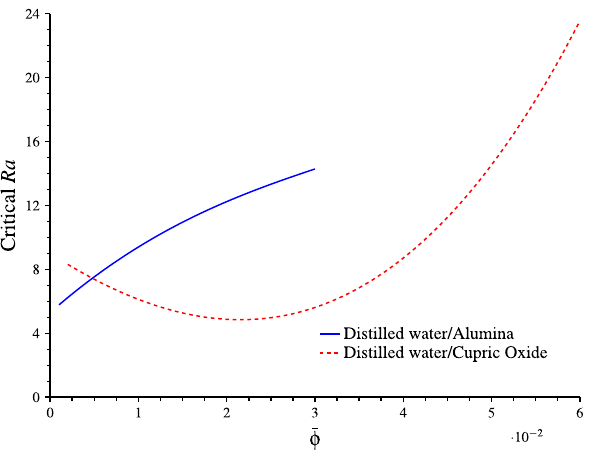
Figure 1: The relation between the volume fraction of nanoparticles and the critical thermal Rayleigh number for a DW/alumina nano fl uid and DW/cupric oxide nano fl uid based on the model of Kanafer and Vafai.